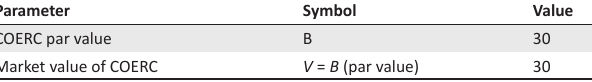
TABLE 5: Assumptions underlying a numerical Call Option Enhanced Reverse Convertible example. Parameter